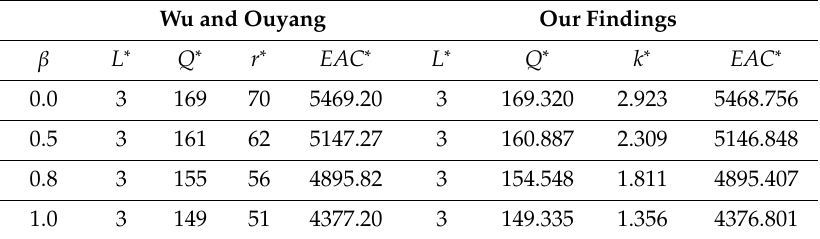
Table 3. Comparison of ours and that of Wu and Ouyang [2]. Wu and Ouyang Our